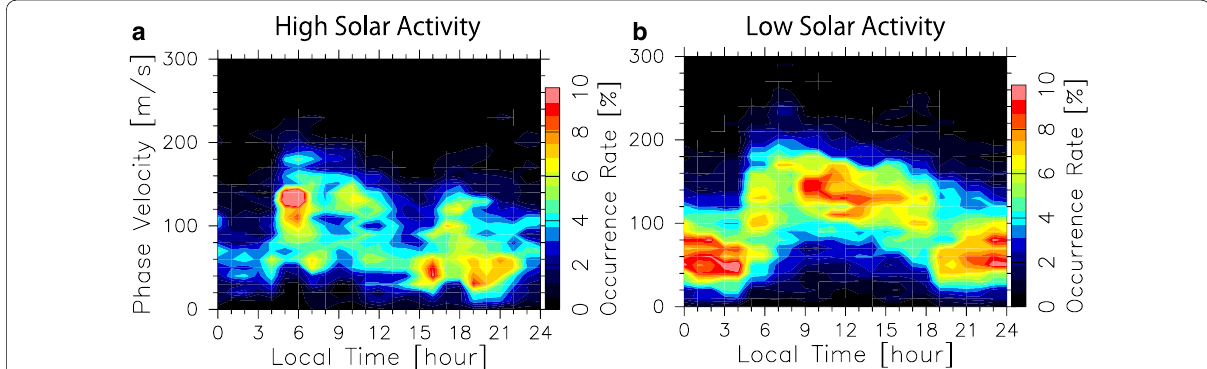
Fig. 8 Local time variation of horizontal phase velocity distribution of MSTIDs in winter (January and December) observed in Japan under a high and b low solar activity conditions. Occurrence rate of the phase velocity was obtained in each hourly and 10-m/s